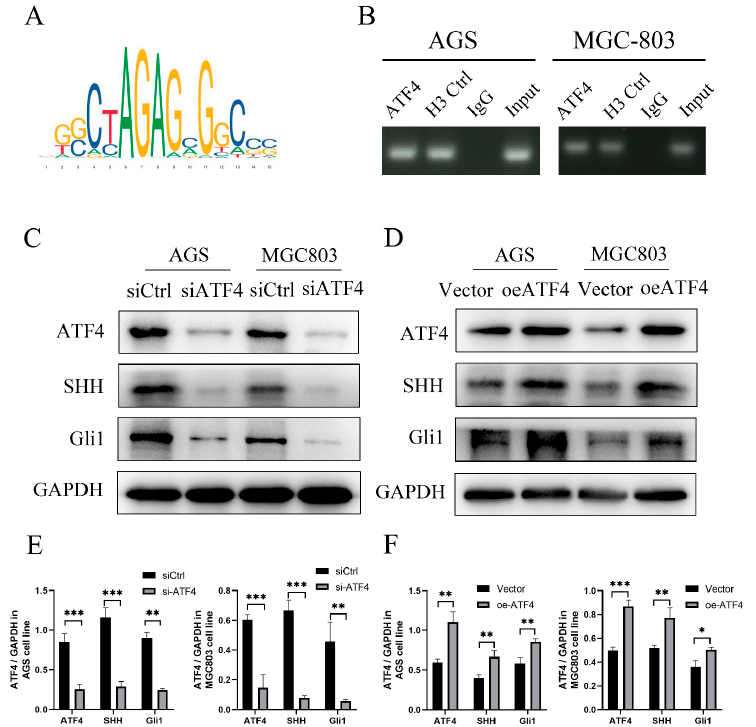
Figure 4. ATF4 binds to the promoter region of SHH to activate the Sonic Hedgehog pathway. ( A ) ATF4 is predicted to be able to bind to the SHH promoter sequence in the JASPA database. ( B ) ATF4 recruitment to the SHH promoter was further demonstrated by the findings of chromatin immunoprecipitation (ChIP) tests in AGS and MGC803. ( C ) Knockdown of ATF4 dramatically decreased SHH protein and downstream Gli1 protein in the Sonic Hedgehog pathway in the AGS and MGC-803. ( D ) The AGS and MGC-803 cell lines greatly boosted the expression of SHH and GLI proteins when we overexpressed ATF4. ( E , F ) Quantification of Western blot analysis by Image J software. * p < 0.05, ** p < 0.01, and *** p < 0.001. The original western blot figures could be found in Supplementary S2.